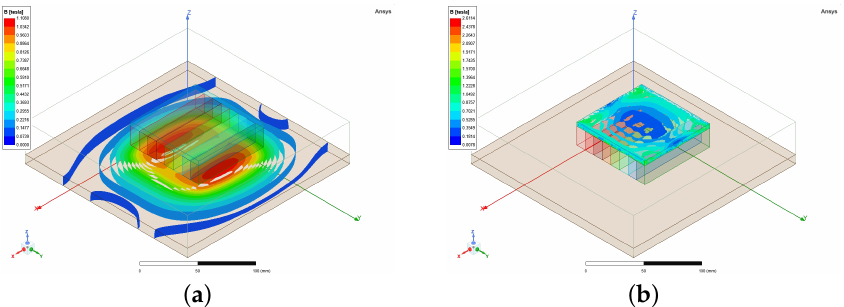
Figure 12. Simulation results for PMAD magnetization. ( a ) Cloud map of the magnetic flux intensity on the test steel plate. ( b ) Cloud map of the magnetic flux intensity on the yoke.